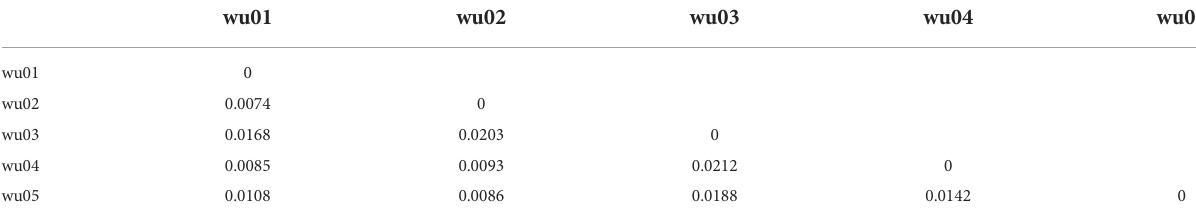
TABLE 3 Pairwise genetic differentiation ( F st ) matrix between fi ve Phragmites australis